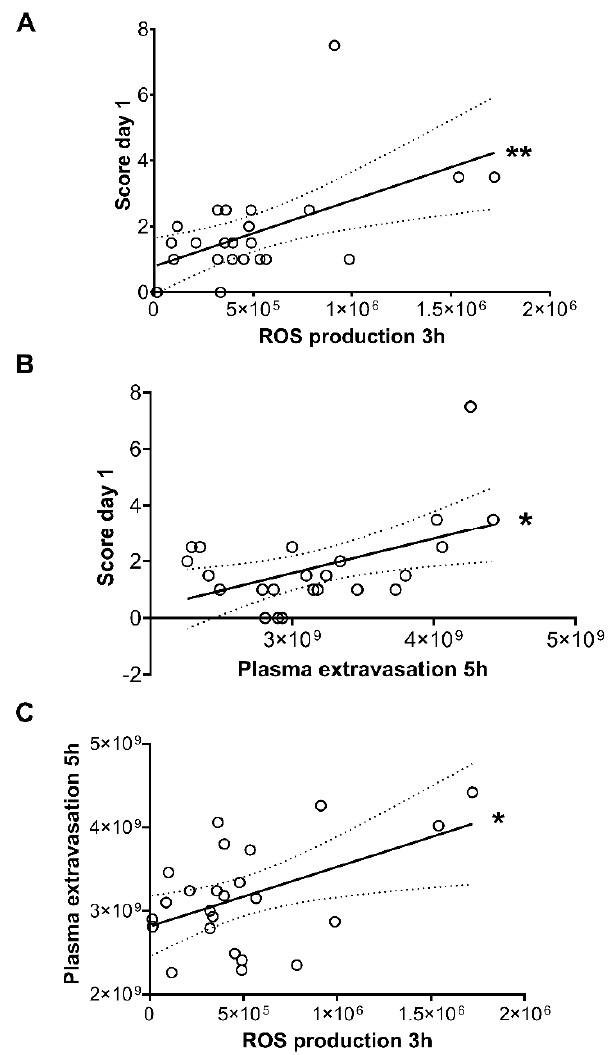
Figure 6. Linear regression and correlation of ( A ) L-012 luminescence signal at 3 h and the clinical severity score on day 1. ( B ) Fluorescent vascular signal at 5 h and the day 1 score, ( C ) the vascular fluorescent signal and the L-012-derived luminescence. All matched data pairs shown from both non-pretreated and RTX-pretreated groups. * p < 0.05, ** p < 0.01.